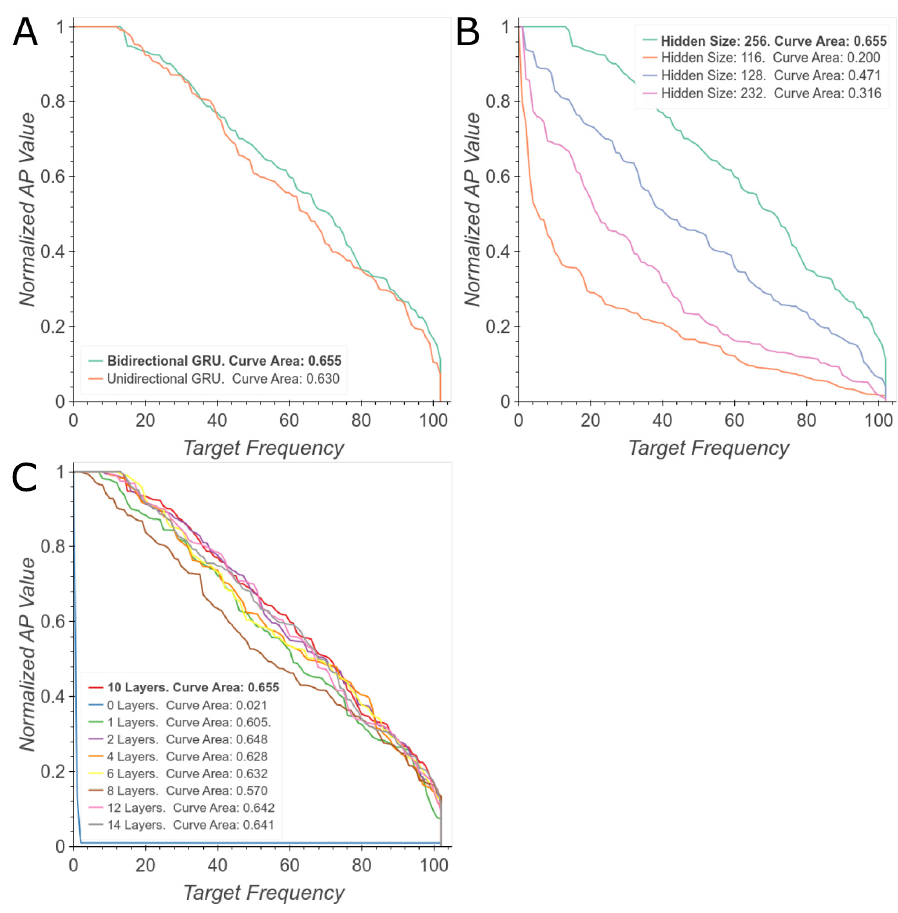
Fig 6. Ablation study of GRU’s architecture. (A) Unidirectional vs. Bidirectional GRU. (B) Hidden State Size. (C) GRU’s depth. Best viewed in color.